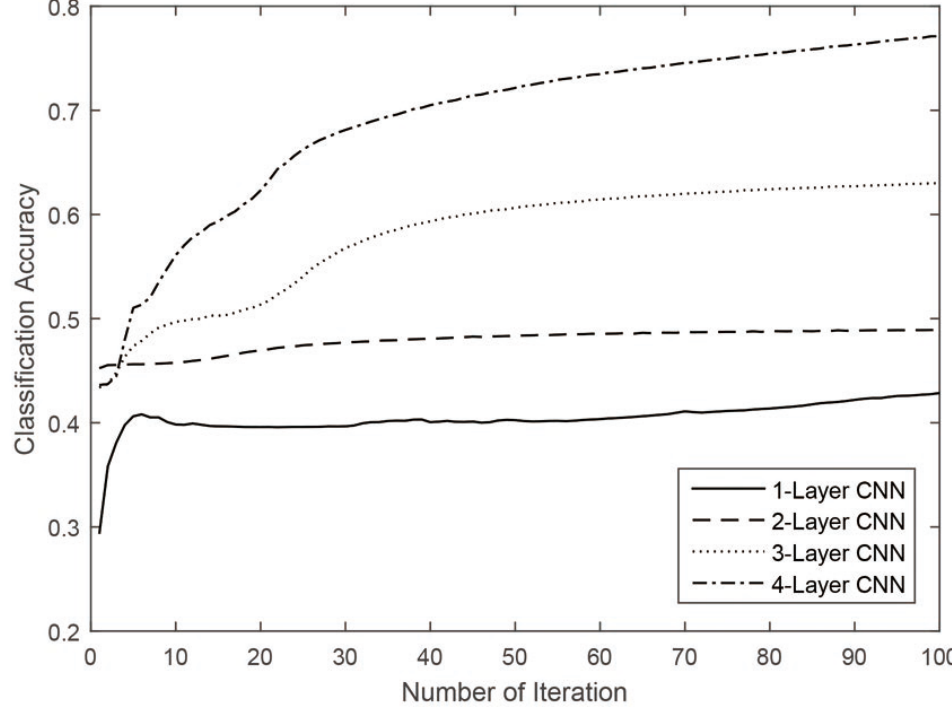
Figure 4. Overall accuracies of the university of Pavia dataset classified by CNN under different